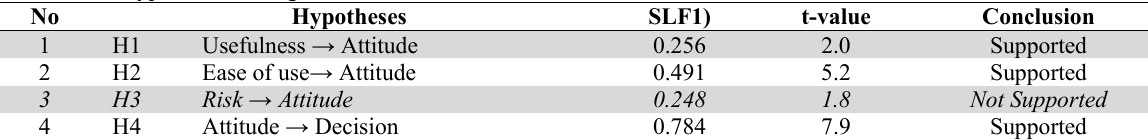
The results of hypotheses